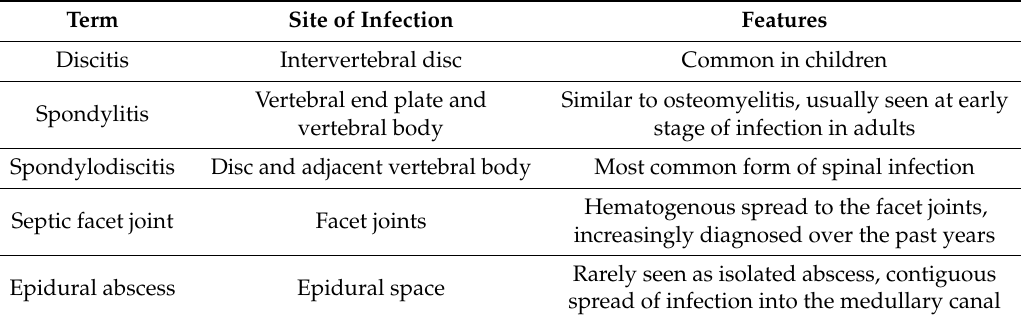
Table 1. Terminology of the spinal